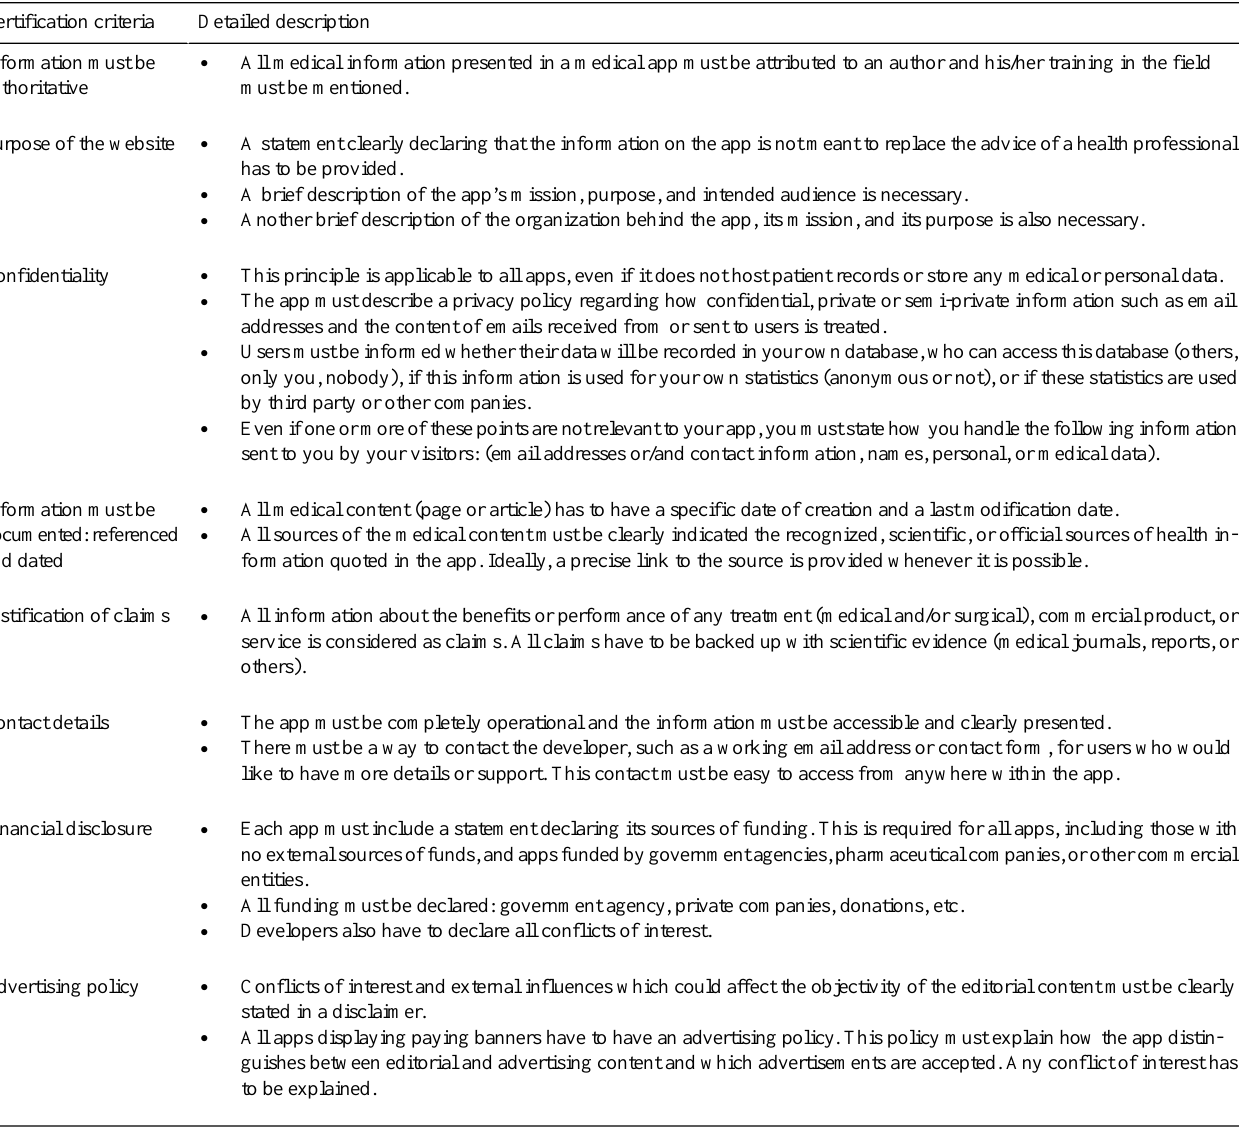
Table 1. A list of potential criteria based on the HONcode to be used as the basis of a self-certification model for medical apps. Detailed descriptionCertification